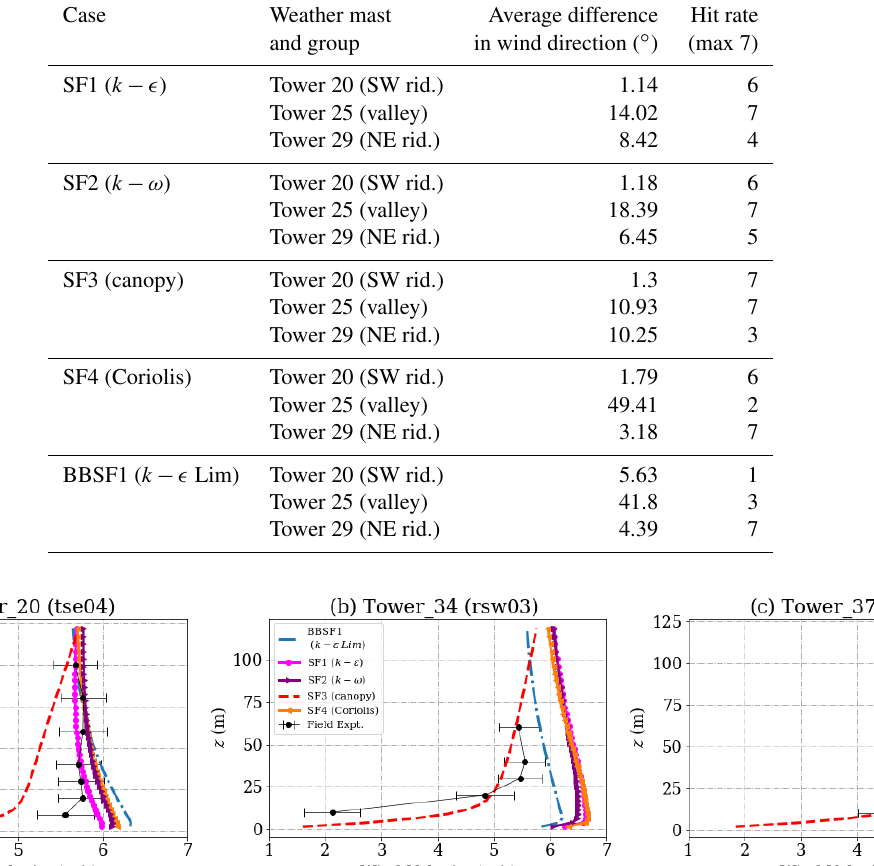
provides the hit rate for different models at all the